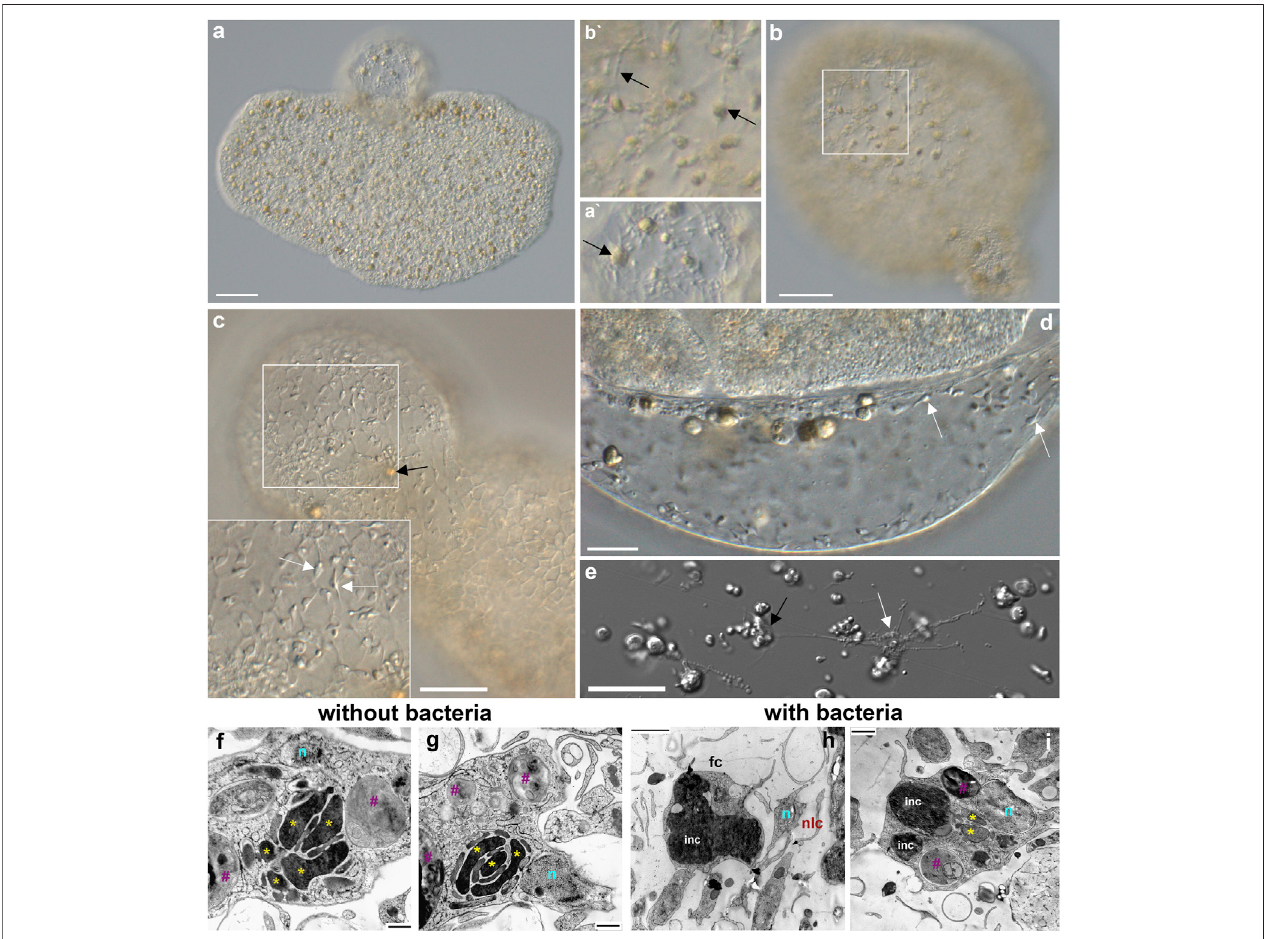
FIGURE 8 | Fiber cells in spherical structures (A – C) and their microanatomy (F – I) . Both fi ber cells (black arrows) and smaller neuroid-like cells (white arrows) are presentin “ spheres ’” . (A) — Trichoplaxadhaerens withasphereontheupperside. A 9 – apartofthespherewithtwo fi bercells(arrow). (C,D,E) — smallerneuroid-likecells (white arrows) with elongated processes (E) that can form connections among themselves and fi ber (black arrow) cells (Romanova et al., 2021). Both cell types are locatedinthemiddlelayerofplacozoans (B/B 9 ) . (F – I) — Transmissionelectron microscopy(TEM)ofthe fi bercellsin Rickettsia -free Trichoplax (ampicillin-treatedfor 12 months)andcontrolanimalswithendosymbioticbacteria(seealso Figure7B ).Ofnote, fi bercellsinampicillin-treatedpopulationsofplacozoanshadmoreelaborate mitochondrial clusters and clear inclusions. In contrast, in animals with bacteria, fi ber cells possessed large dark (by TEM) inclusions (light microscopy also shows brownish inclusions — black arrows in A – C ). Yellow asterisks (*) -mitochondria, n — nuclei, purple # — clear inclusions, inc — dark inclusions, fc — fi ber cells, nlc — neuroid- like cells.